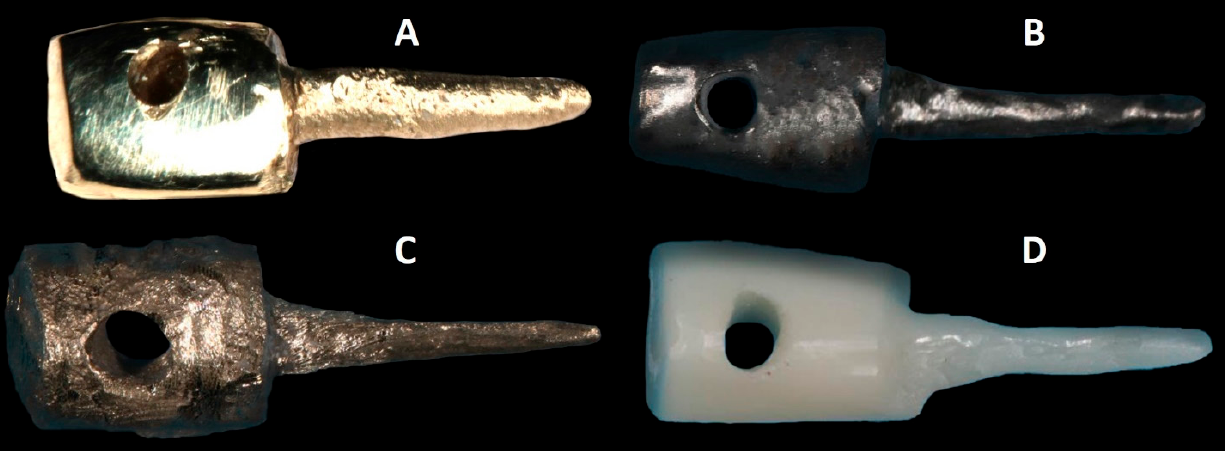
Figure 5. ( A ) Custom-cast non-precious post and core. ( B ) Custom-milled titanium post and